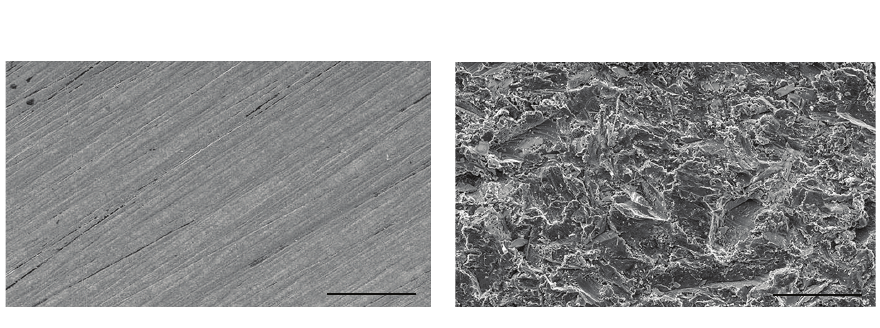
Medetomidine (0.2 mg/kg-Domitor), Ketamine (10 mg/kg- Imalgene 1000), and Butorphanol (0.5 mg/kg-Nargesic)